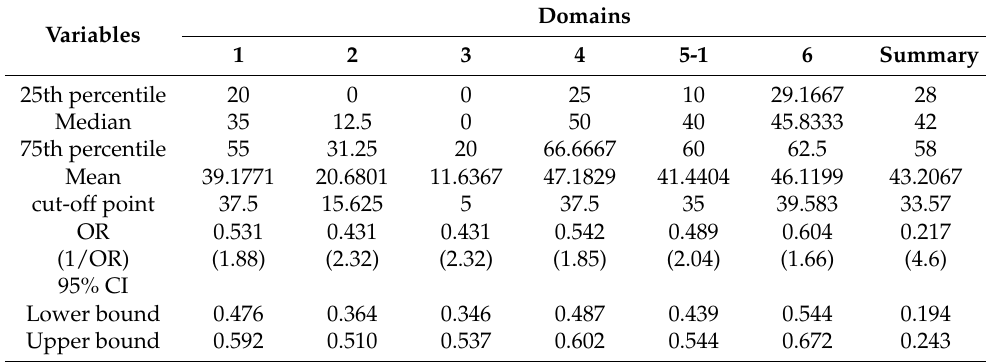
Table 5. Summary WHODAS 2.0 scores and area under the curve in the six separate domains a .